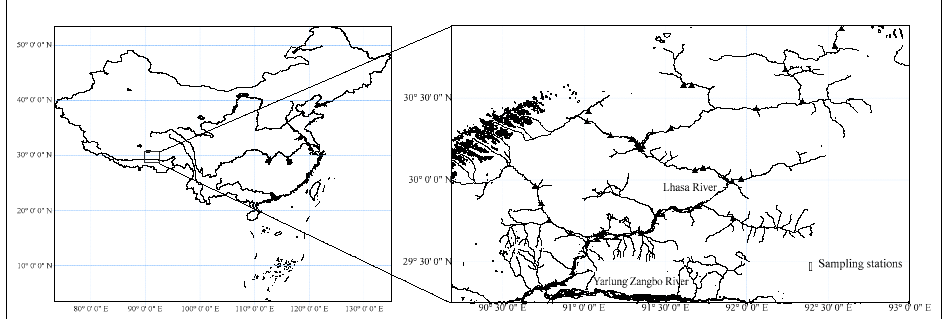
Figure 1. Distribution of sampling stations.